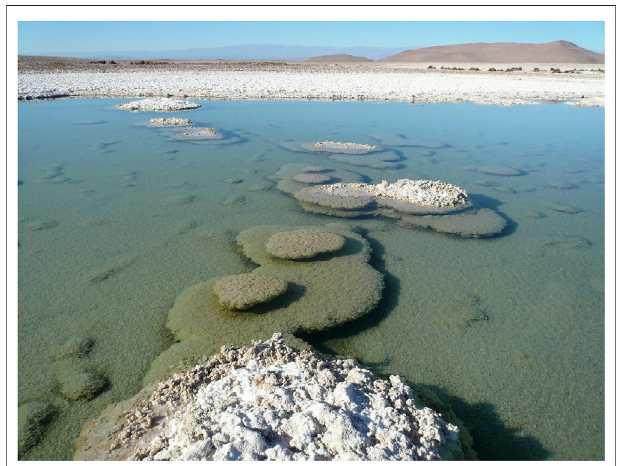
FIGURE 14 | Salar de Llamara salt pan, showing submerged gypsum stromatolite-like structures.